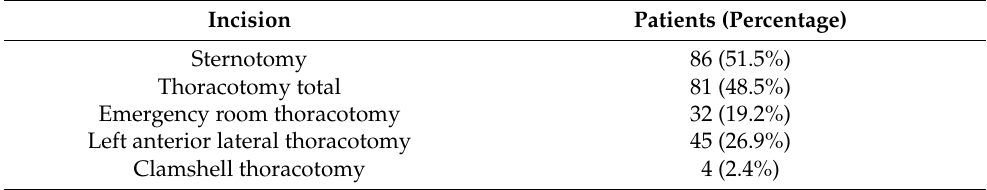
Table 4. Type of incision.